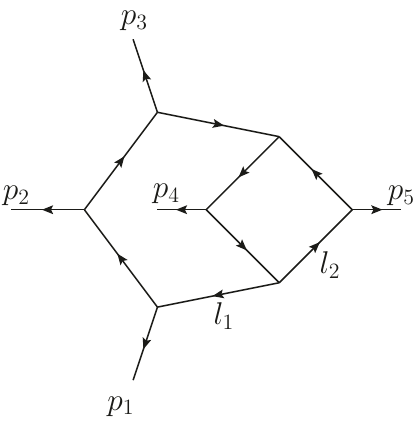
Figure 3 . The nonplanar pentabox integral with massless propagators and external legs with zero